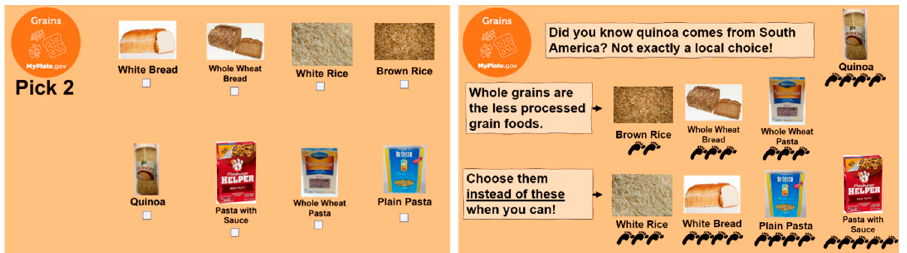
Figure 3. Sample materials from “Supermarket Sweep for Sustainability.” On the left is an example of the grocery items from the grains group from the lesson’s online version. On the right, the “carbon footprints” of the grain items are revealed on the lesson’s slide presentation. All lesson materials are available at https://www.efnephelps.org/revitup (accessed on 30 September 2021).